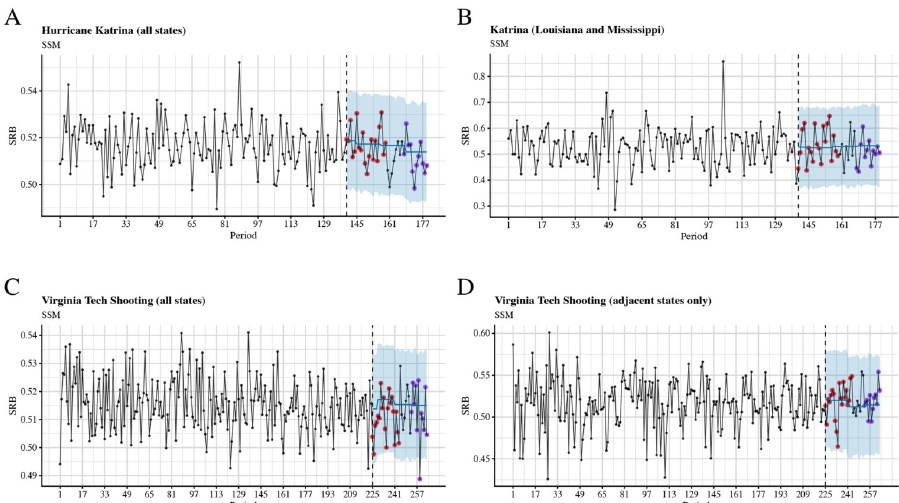
Fig 4. Time series plots and out-of-sample forecasts for SRB data grouped into 7-day periods and fitted with state space models. The blue shade is the 95% confidence level. The observed SRBs for the first five months after the intervention are presented by red dots, whereas the observed SRBs for 7 to 9 months after the intervention are presented by purple dots. A: Hurricane Katrina, all states; B: Hurricane Katrina, Louisiana and Mississippi only; C: Virginia Tech shooting, all states; D: Virginia Tech shooting, adjacent states